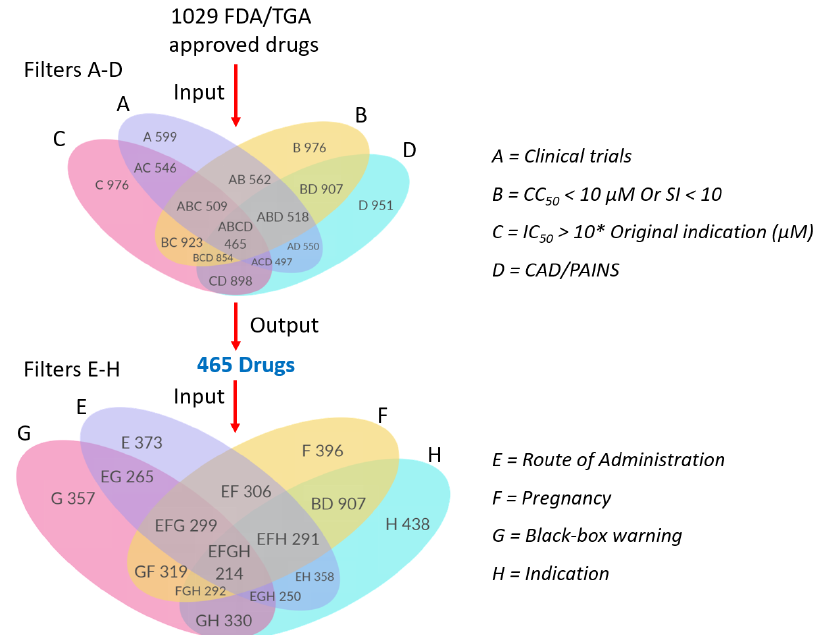
Figure 4. Down-selection of drugs based on indicators of efficacy and safety (A – D and E – H); * =